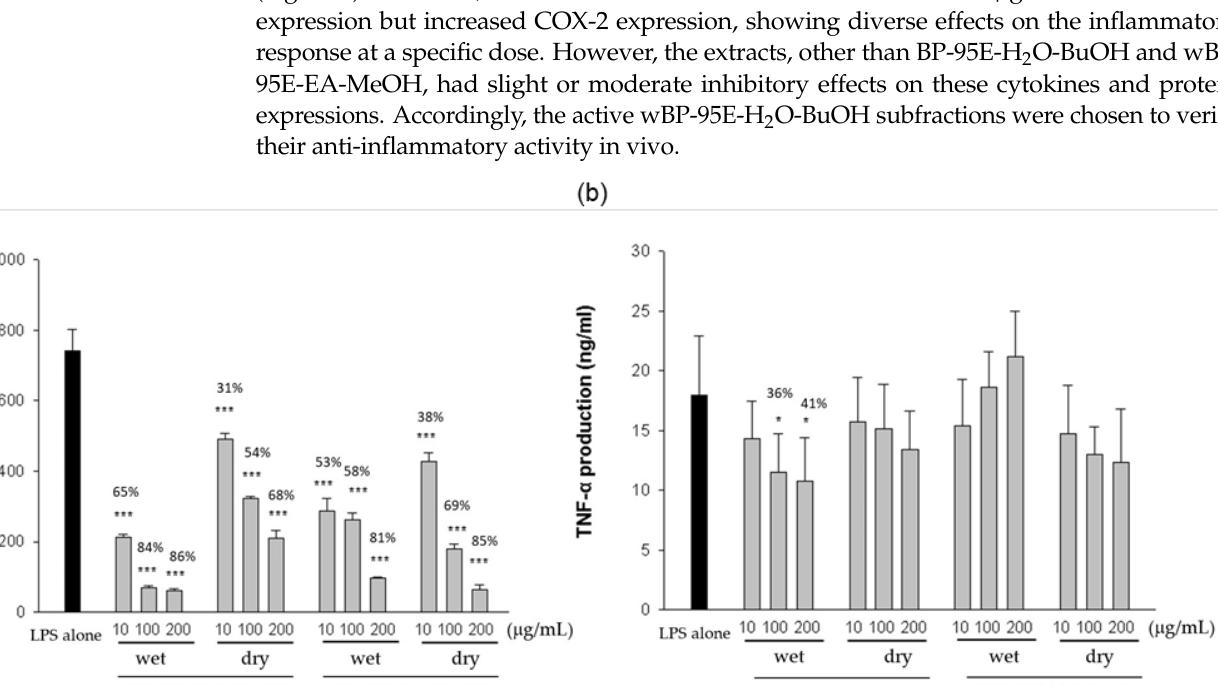
Figure 3. Effects of butanol and methanol subfractions of BP on iNOS or COX-2 protein expressions in LPS-stimulated RAW264.7 cells. Cells were pretreated with the indicated BP extracts for 1 h and